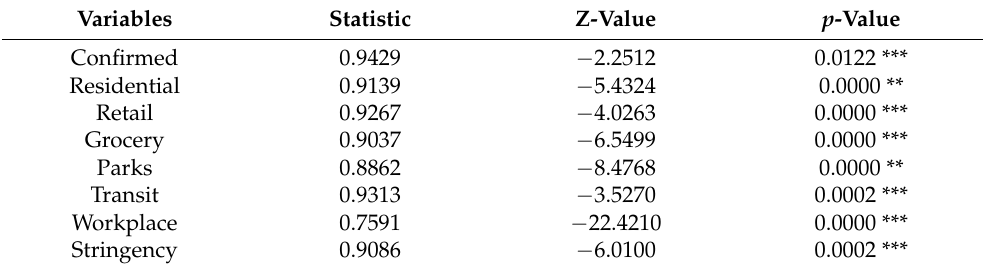
Table A2. Unit root test results.